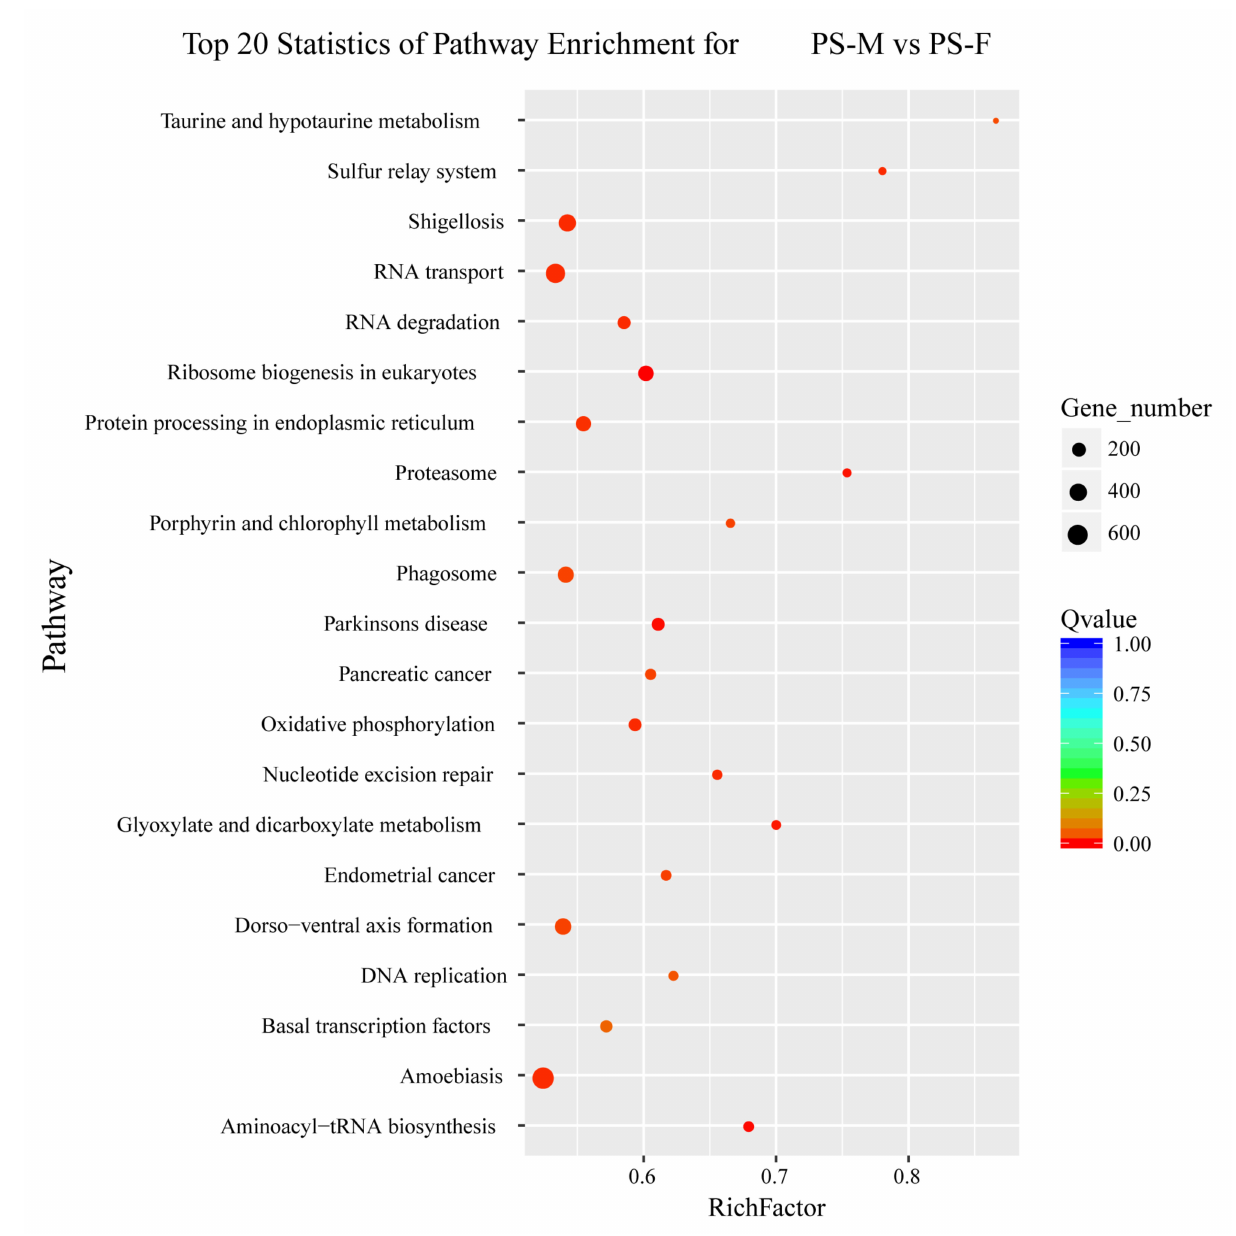
Figure 3. Top 20 statistics of pathway enrichment for PS-M vs. PS-F. PS-M represents the male Portunus sanguinolentus and PS-F represents female Portunus sanguinolentus